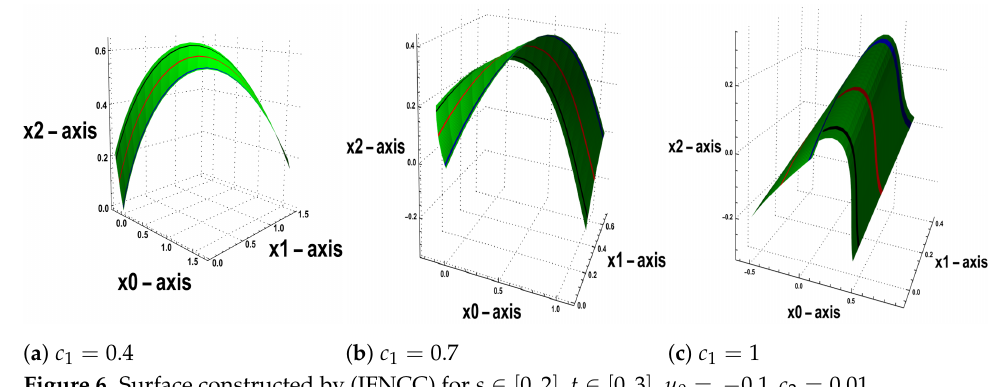
Figure 6. Surface constructed by (IFNCC) for s ∈ [ 0,2 ] , t ∈ [ 0,3 ] , µ 0 = − 0.1, c 2 = 0.01. At the constant binormal velocity µ 0 = 0.3, we plot the family of (IFNNC) and the generated surface from the family of (IFNCC), as illustrated in Figures 7 and 8. The curves with blue, red, and black colors represent the evolution of the (NCC) at t = 0.1, 1.4, 2.6 for s ∈ [ 0, 2 ] , t ∈ [ 0, 3 ] , and c 2 = 0.01.